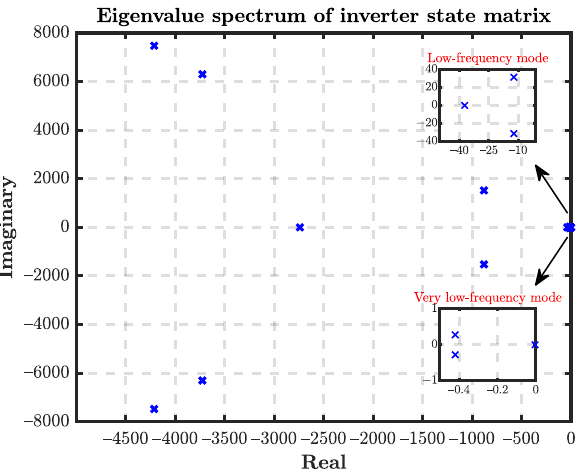
Figure 4. The eigenvalues of the small-signal model of the islanded MG with one inverter. The comparison of the small-signal average model of the islanded MG with one inverter and the large-signal switched model is shown in Figure 5. The islanded MG operation point changes from a normal one to another operating condition with 100% load step change.